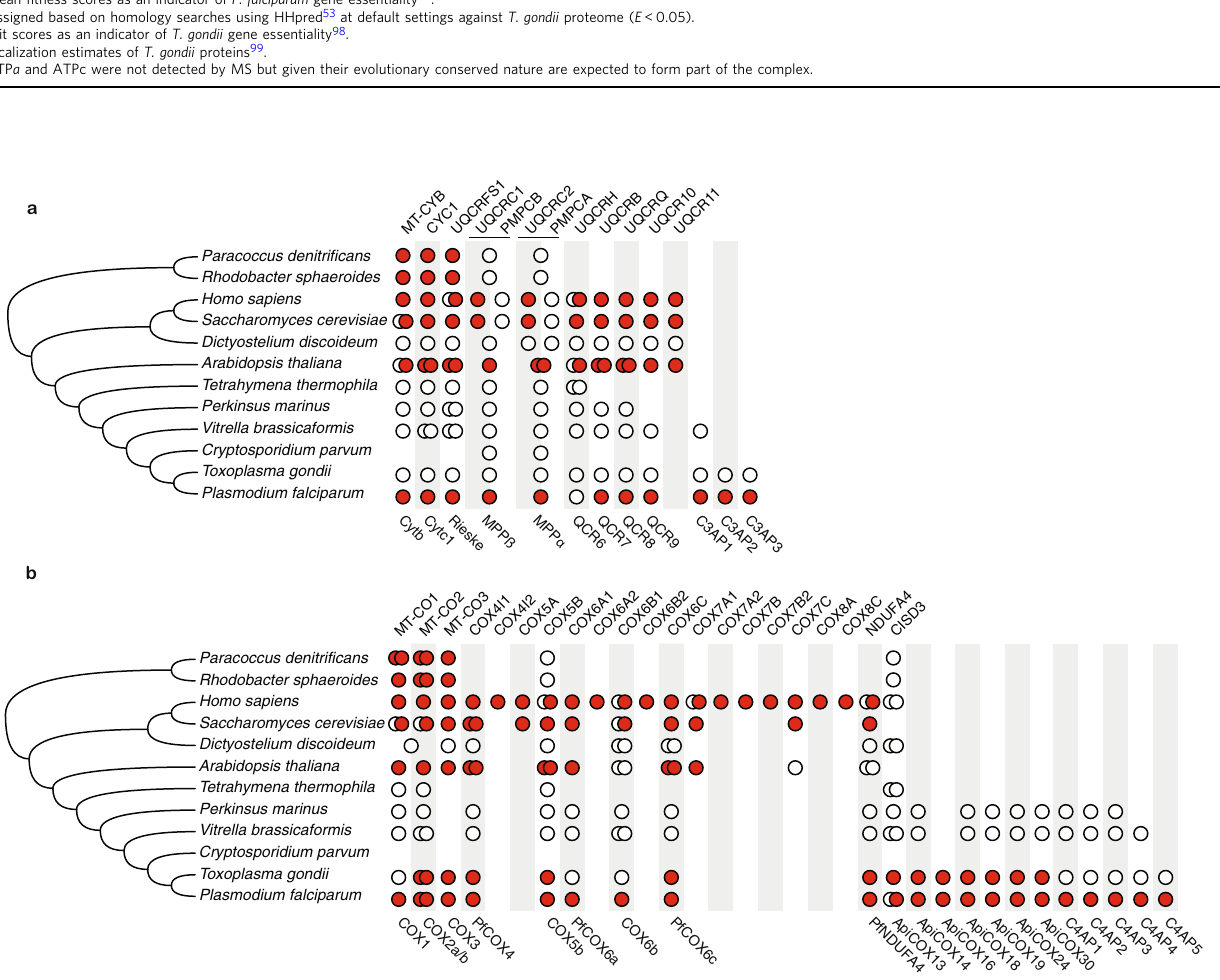
Fig. 4 Evolution of complex III and IV subunit composition in model species and in the lineage leading to Plasmodium falciparum . The subunit compositions of complex III ( a ) and complex IV ( b ) are based on data from model species and proteins from P. falciparum found to comigrate with that complex in this study. Colours depict levels of evidence (red, experimental evidence; white, genomic evidence) linking the subunit to the enzyme. Double circles represent the presence of paralogues and their colour indicates experimental evidence linking them to the complex. For PMPCA/UQCRC2 and PMPCB/UQCRC1, in cases where there has not been a gene duplication, the protein is indicated in the middle between the two columns. Human gene symbols are shown on top; P. falciparum gene names are shown below the conservation